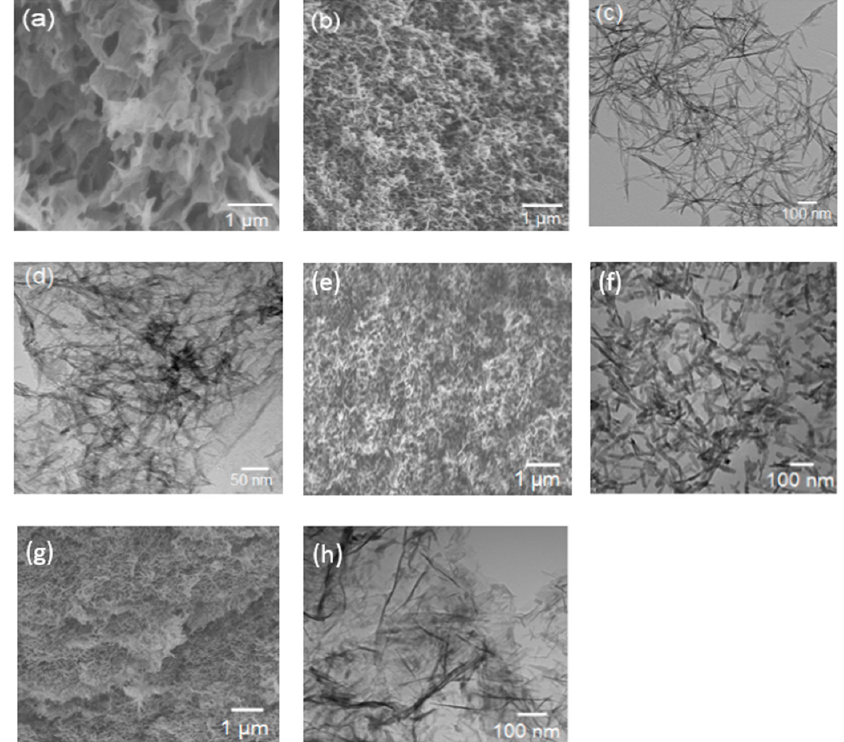
Figure 1. ( a – d ) correspond to Method I: SEM images of ( a ) rGO aerogel and ( b ) V 2 O 5 aerogel; TEM images of ( c ) V 2 O 5 aerogel and ( d ) rGO-V 2 O 5 -0.82 hybrid aerogel. ( e – h ) correspond to Method II. ( e ) SEM and ( f ) TEM images of V 2 O 5 aerogel; ( g ) SEM image of V 2 O 5 -rGO-6 hybrid aerogel; and ( h ) TEM image of V 2 O 5 -rGO-6 hybrid aerogel.